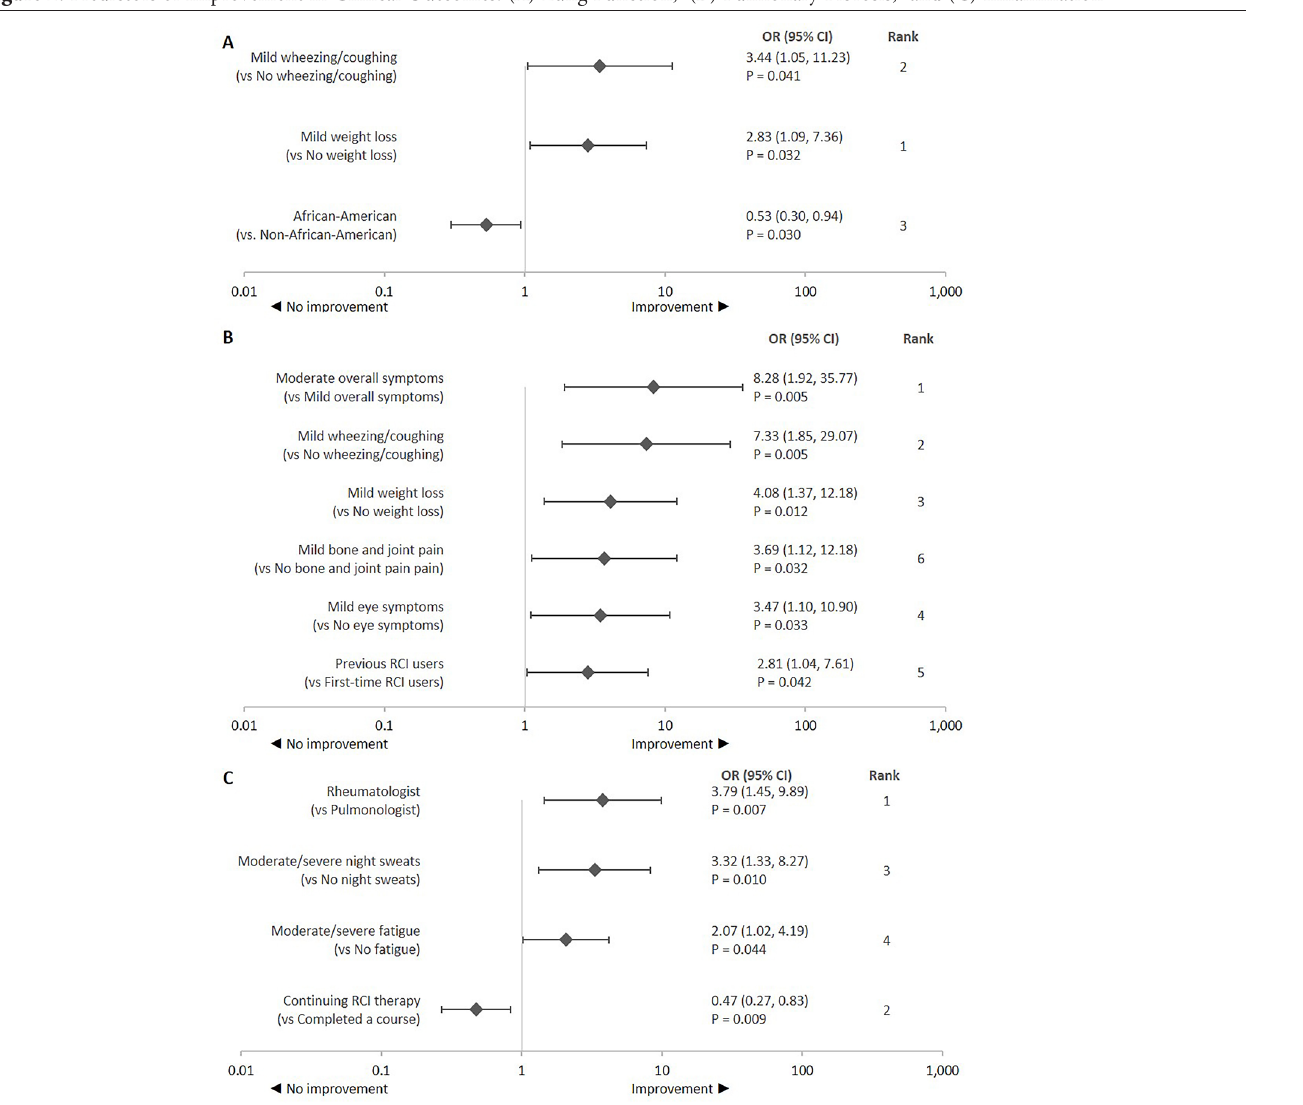
Figure 2. Predictors of Improvement in Clinical Outcomes: ( A ) Lung Function, a ( B ) Pulmonary Fibrosis, b and ( C ) Inflammation